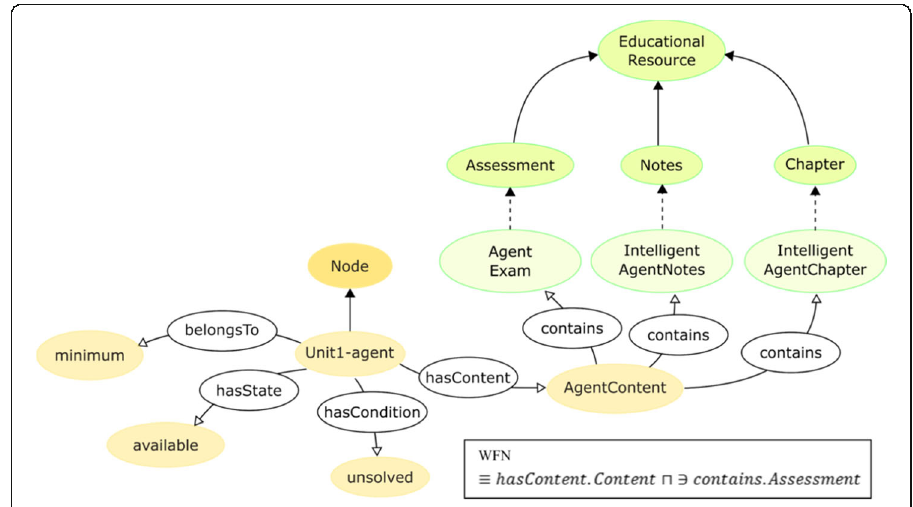
Fig. 7 Example of instances in the Learning Path ontology